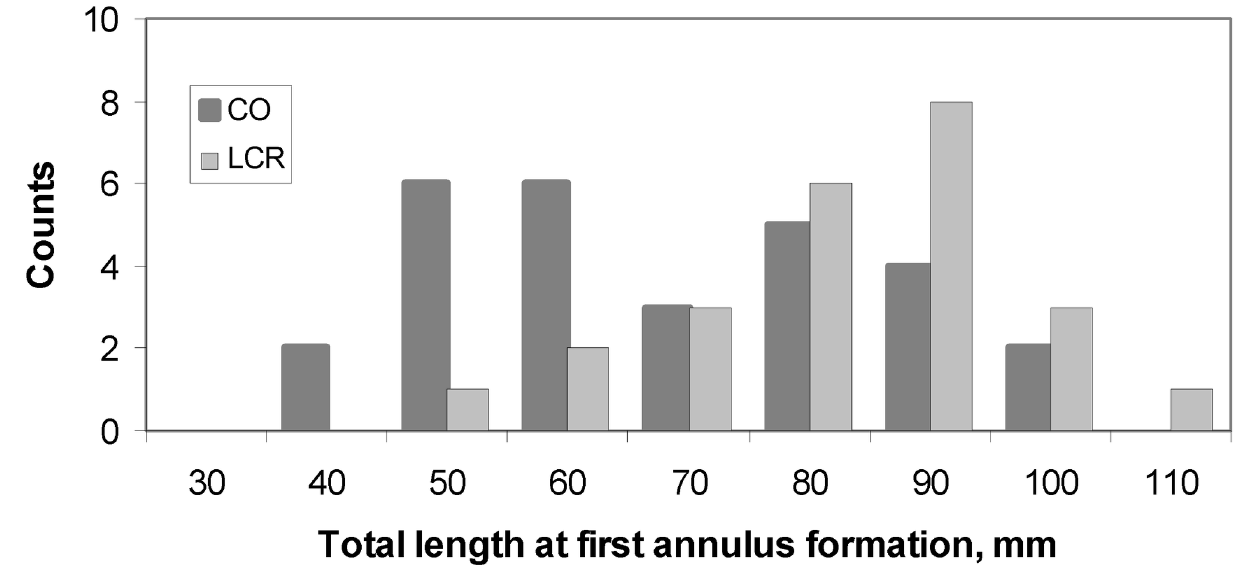
Figure 9. Back calculated lengths at first annulus formation for humpback chub captured in the Little Colorado (Little Colorado River) vs. Colorado (CO) rivers .